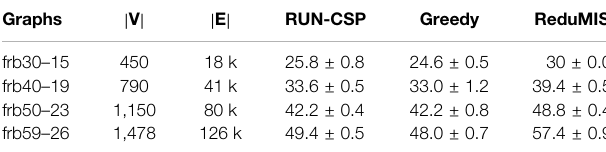
TABLE 7 | M AX -IS: Achieved IS sizes for the benchmark graphs. We report the mean and std. deviation for the fi ve graphs in each group.